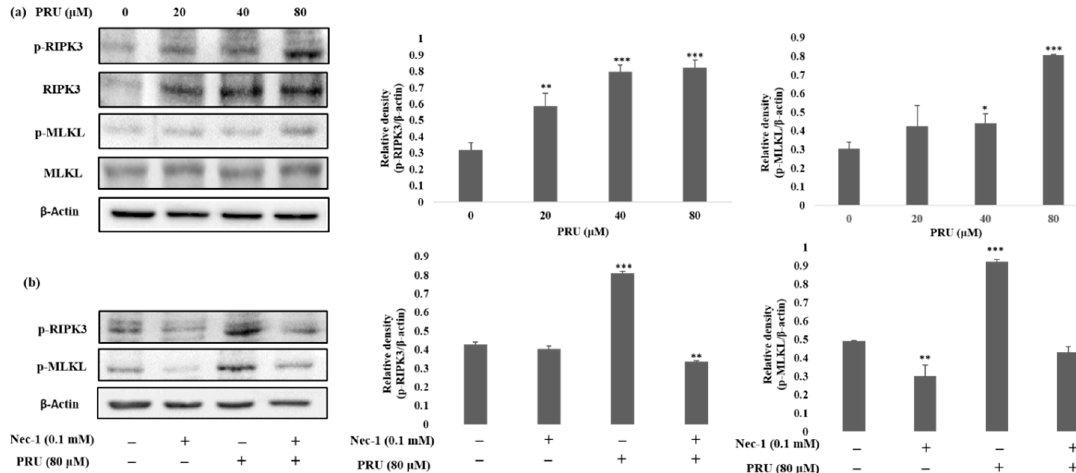
Figure 5. PRU induces necroptosis related cell death via RIPK3 and MLKL expression in AGS cells. ( a ) Western blot analysis of necroptosis protein markers RIPK3, p-RIPK3, MLKL, and p-MLKL protein expression on PRU treated AGS cells. The expression levels of phosphorylated form of RIPK3 and MLKL are represented graphically based on its densitometry. ( b ) Protein expression of p-RIPK3 and p-MLKL analyzed by western blot on PRU treated AGS cells with and without co-treatment with necrostatin-1 inhibitor (0.1 mM). The expression of the protein levels is represented graphically based on its densitometry. Values are given as the mean ± standard error of the mean (SEM) of three independent experiments. * p < 0.05 vs. control, ** p < 0.01 vs. control, *** p < 0.001 vs. control.